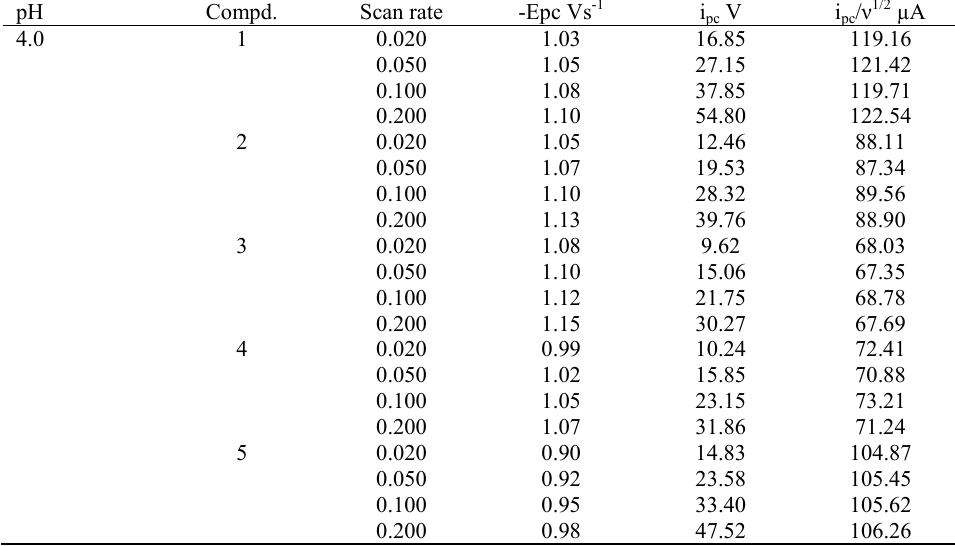
Table 3 . Cyclic voltammetric data of compounds 1-5 at pH 4.0 Conc. = 1 mM, Medium = 65% (V/V) DMF. pH Compd.